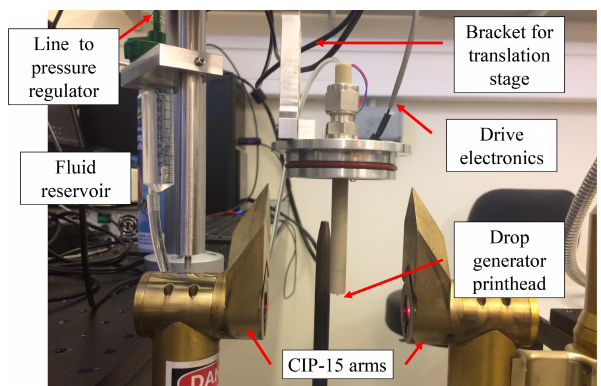
Figure 1. A photograph of the droplet generator injecting droplets into the sample volume of the